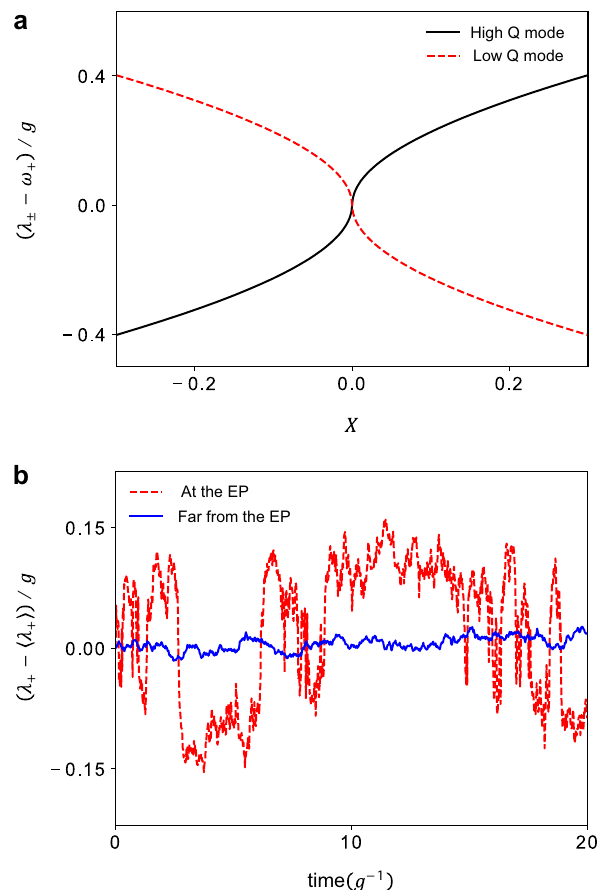
Figure 1. Eigenfrequencies and noise amplification near an EP. ( a ) Real parts of cavity resonance frequencies. Black solid and red dashed lines correspond to high- and low-Q modes, respectively. ( b ) Simulated frequency fluctuation of the high-Q mode at the EP (red dashed line, X 2.0 ). The standard deviation of the parameter X and the correlation time are assumed as follows: � � = − σ X 0.02, τ c 1 / g = =